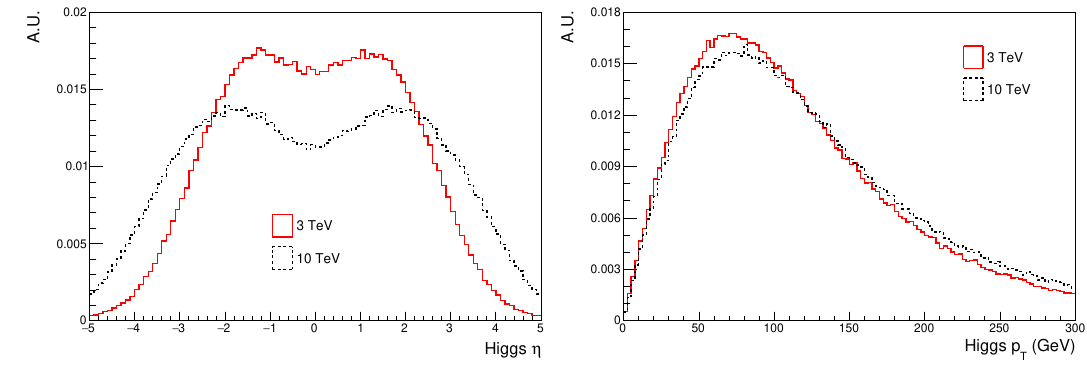
Figure 3 . Normalised Higgs pseudorapidity (left) and transverse momentum (right) distributions for W + W − fusion events at 3 and 10